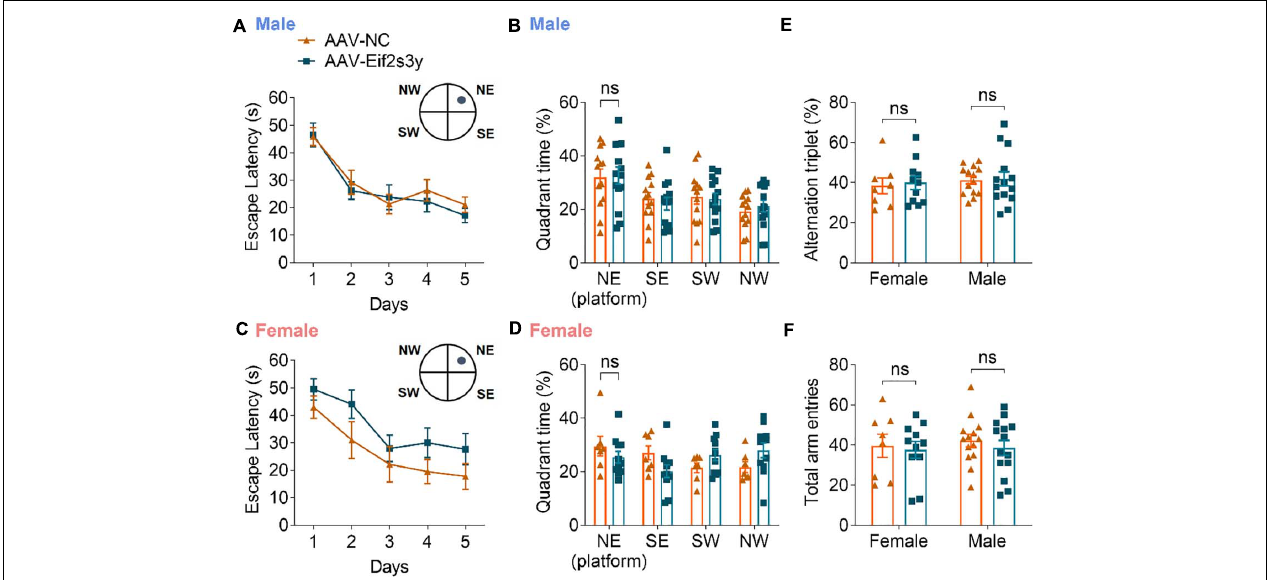
FIGURE 7 | Overexpression of Eif2s3y has no effect on mouse learning and memory. (A–D) In the Morris water maze test, escape latency (A,C) in the training phase and time spent in each quadrant during the probe test phase (B,D) were analyzed for male mice (A,B) injected with AAV-Eif2s3y ( n = 14) or AAV-NC ( n = 13), and female mice (C,D) injected with AAV-Eif2s3y ( n = 11) or AAV-NC ( n = 7). Two-way ANOVA followed by post hoc Sidak’s multiple comparisons test was used for (A,C) . Unpaired t-test was used for (B,D) . ns, not significant. (E,F) In the Y maze test, alternation triplet (E) and total arm entries (F) were analyzed. n = 14 AAV-Eif2s3y male mice, n = 14 AAV-NC male mice, n = 11 AAV-Eif2s3y female mice, and n = 8 AAV-NC female mice. Unpaired t -test was used for (E,F) . ns, not